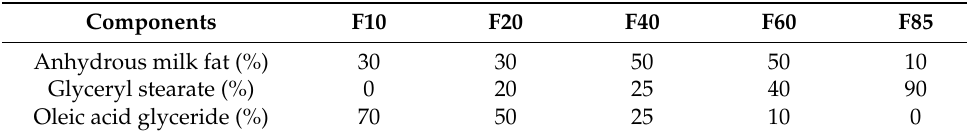
Table 1. Formulas of blended milk